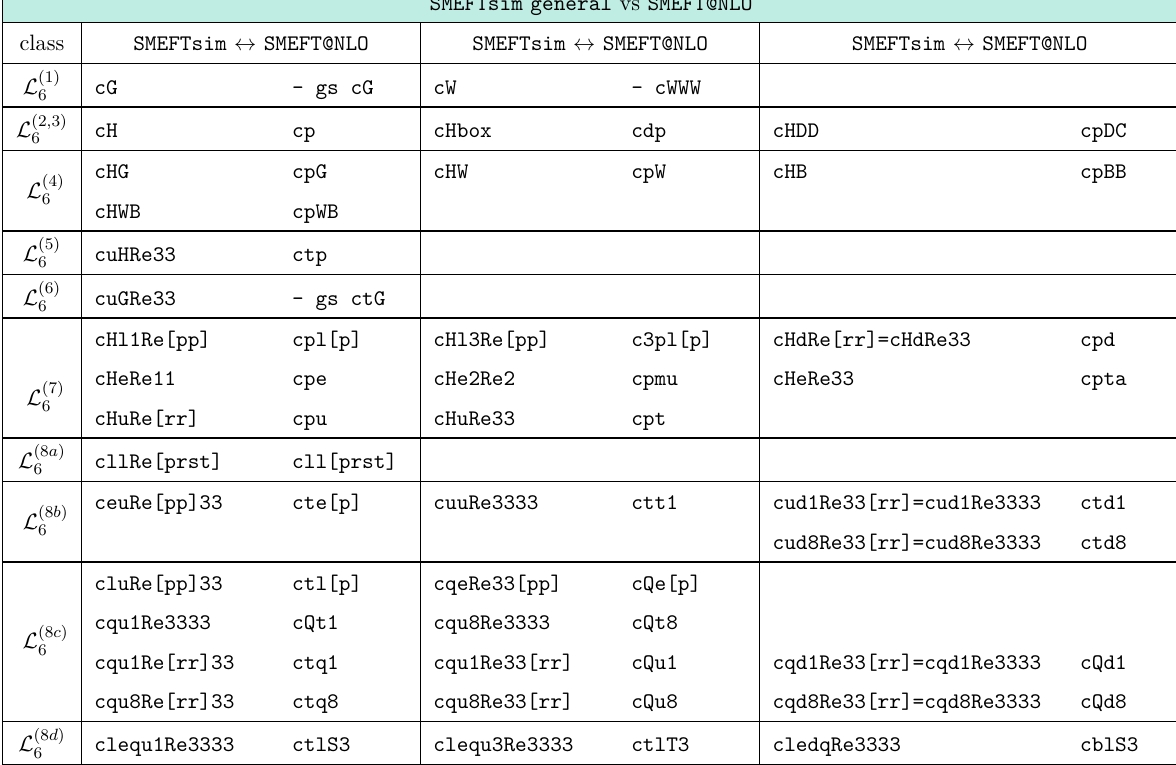
Table 30 . Conversion table between the SMEFT parameters defined in the general version of SMEFTsim and in SMEFT@NLO v1.0 : set of parameters with one-to-one conversion. Lepton flavor indices p take values in { 1,2,3 } . Quark indices r take values in { 1,2 }